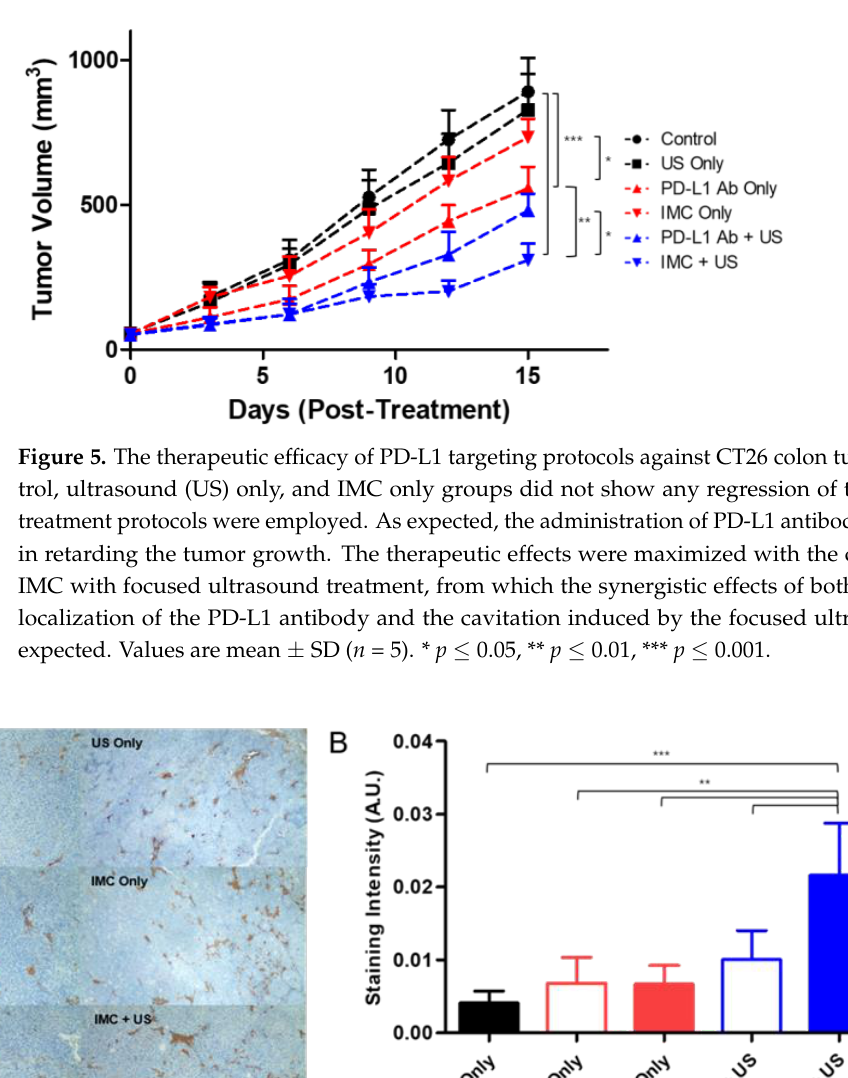
Figure 5. The therapeutic efficacy of PD-L1 targeting protocols against CT26 colon tumors. The control, ultrasound (US) only, and IMC only groups did not show any regression of the tumor after treatment protocols were employed. As expected, the administration of PD-L1 antibody was effective in retarding the tumor growth. The therapeutic effects were maximized with the combi- nation of IMC with focused ultrasound treatment, from which the synergistic effects of both the enhanced localization of the PD-L1 antibody and the cavitation induced by the focused ultrasound can be expected. Values are mean ± SD ( n = 5). * p ≤ 0.05, ** p ≤ 0.01, *** p ≤ 0.001.